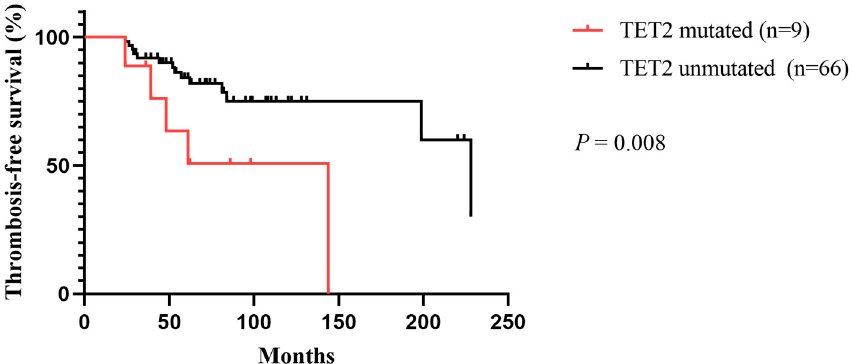
Figure 4. Comparison of TFS in ET patients with and without TET2 mutation.